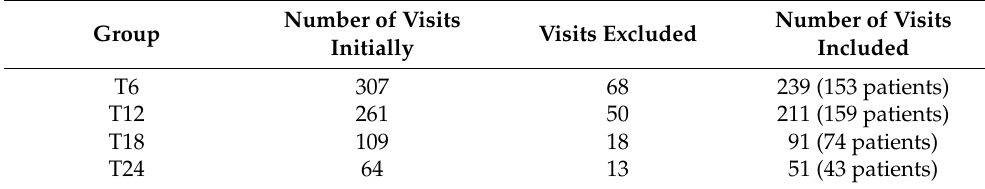
Table 2. Table 2. Group composition (number of visits and